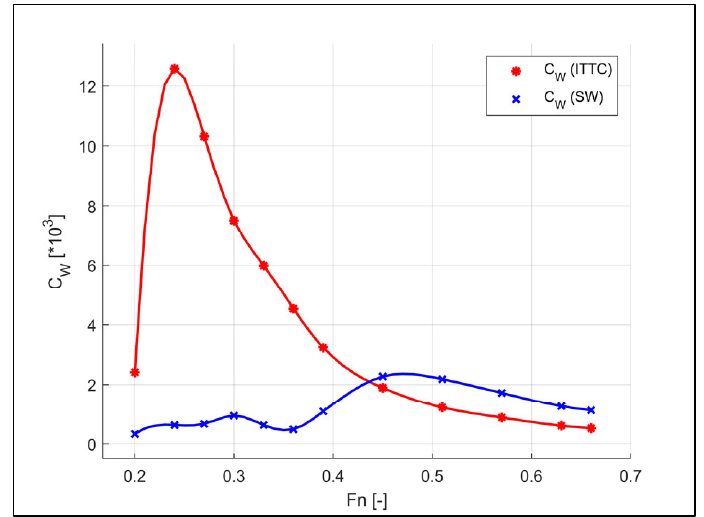
Figure 15. Velocity contours on the centre plane of the demihull at Fr = 0.24 in deep ( top ) and shal ‐ low ( bottom ) waters.